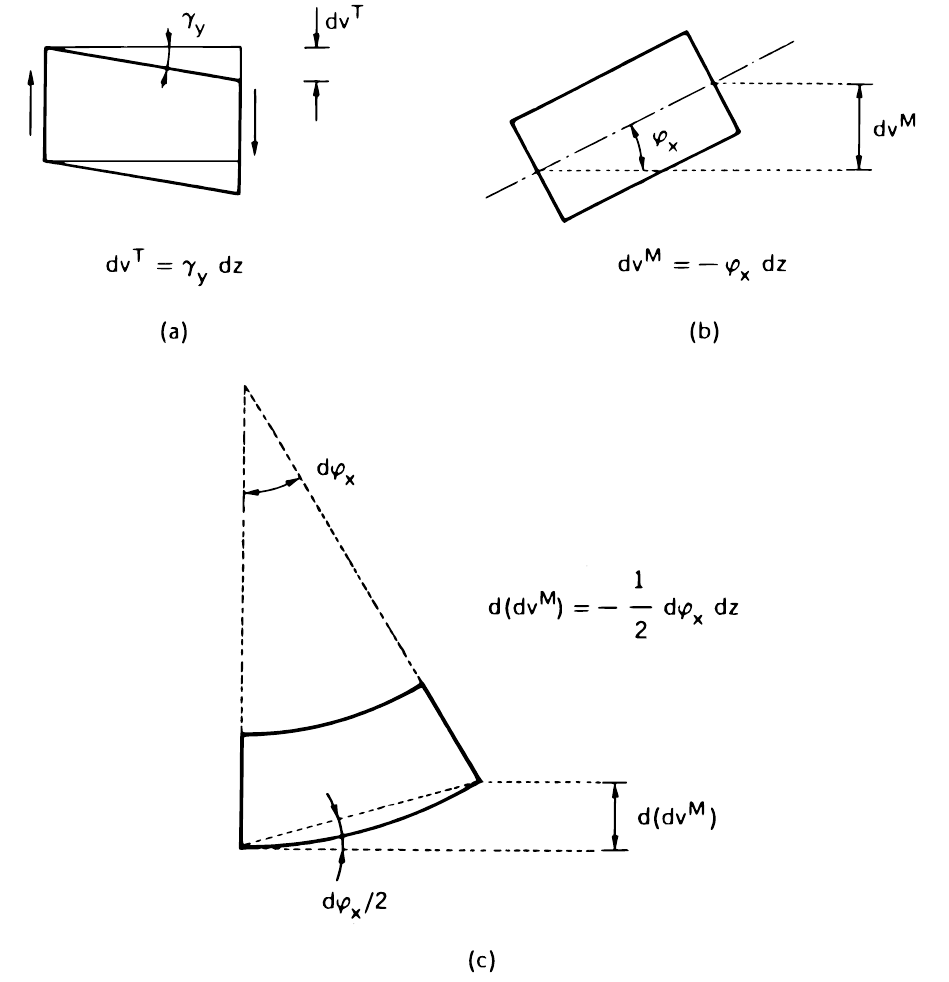
Figure 1: Contributions to the relative transverse displacement in a rectilinear beam due to: (a) shearing strain, (b) rigid rotation, (c) flexural curvature, of the beam